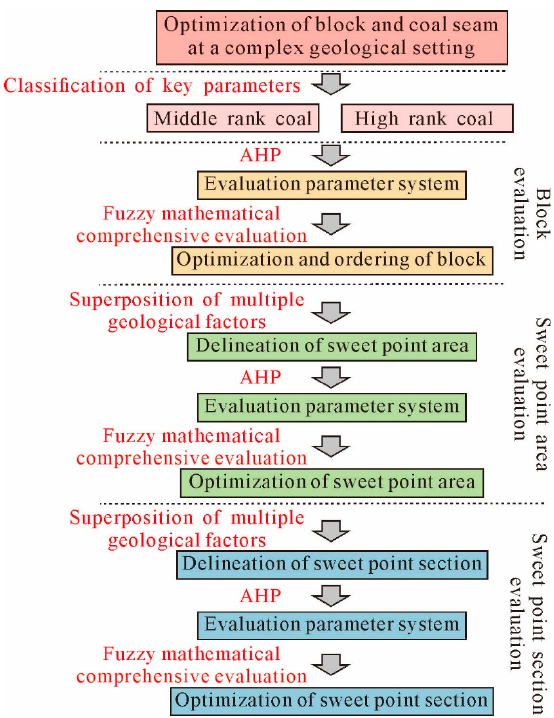
Figure 9. Flow diagram of optimization of block and coal seam for CBM exploration and develop- ment.